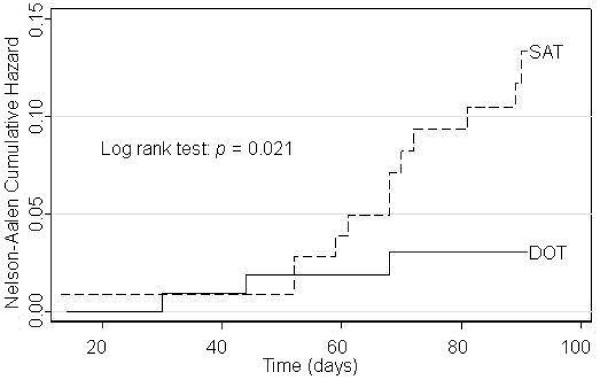
Nelson-Aalen cumulative hazard curves, by treatment group.